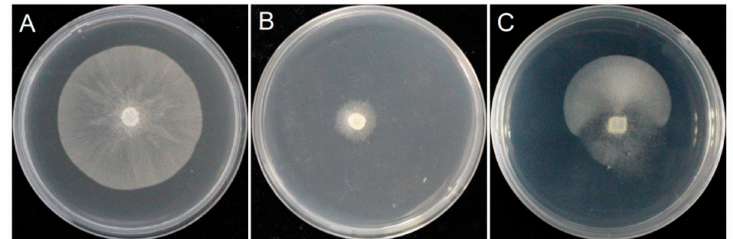
Figure 1. Colony picture of P. capsici . ( A ): Colony morphology of P. capsici SD1 on 10% V 8 medium; ( B ): P. capsici SD1 does not produce mutants on metalaxyl-containing 10% V 8 medium; ( C ): The P. capsici SD1 mutant on metalaxyl-amended 10% V 8 medium (mutant sector).